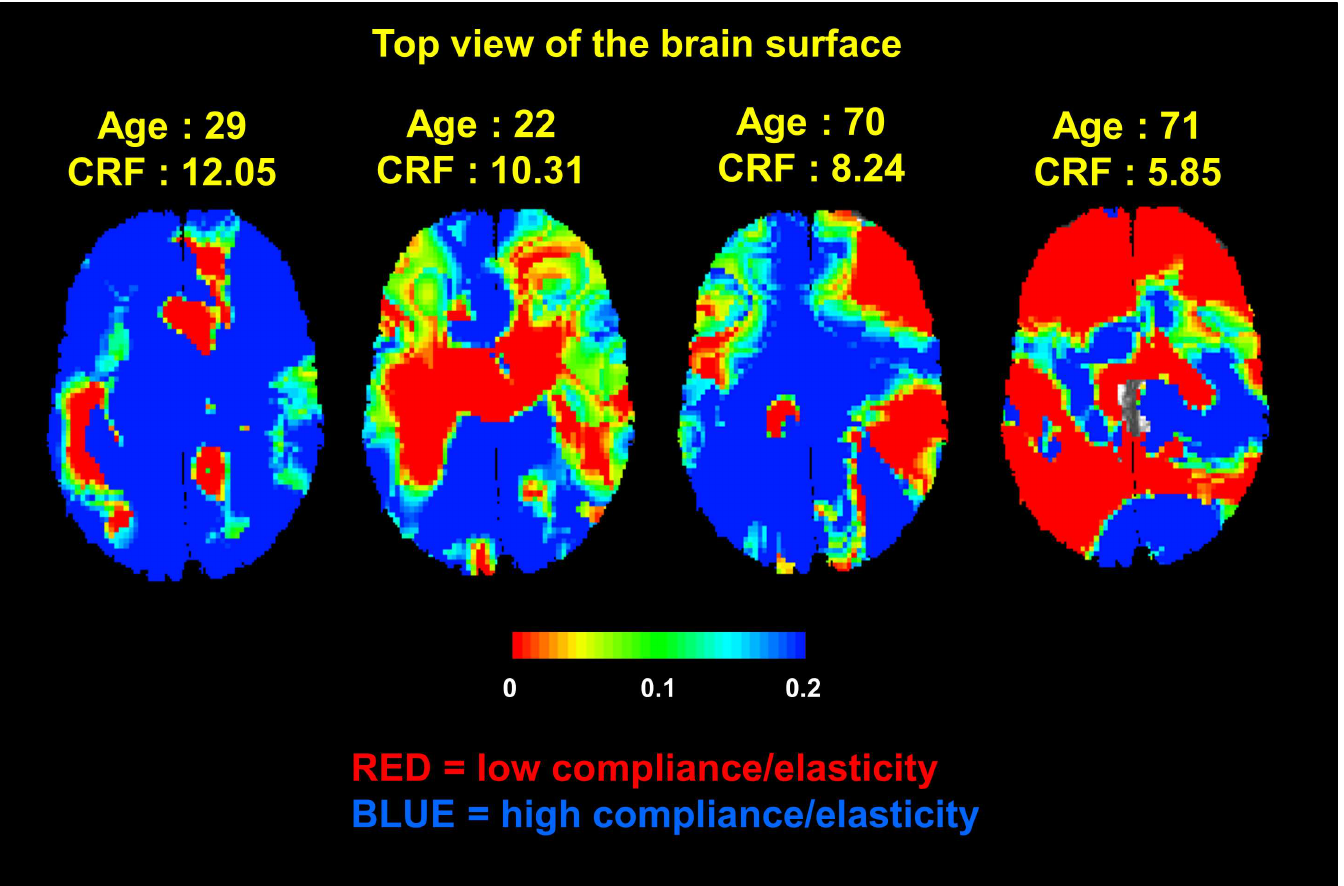
Fig 6. Maps of cortical arterial compliance estimatesin four representative subjects varying in age and eCRF. In each of the maps cortical arterial compliance is projectedonto the brain surface (top view). In general,subjects who are youngerand relativelymore fit show greater arterial compliance(blue